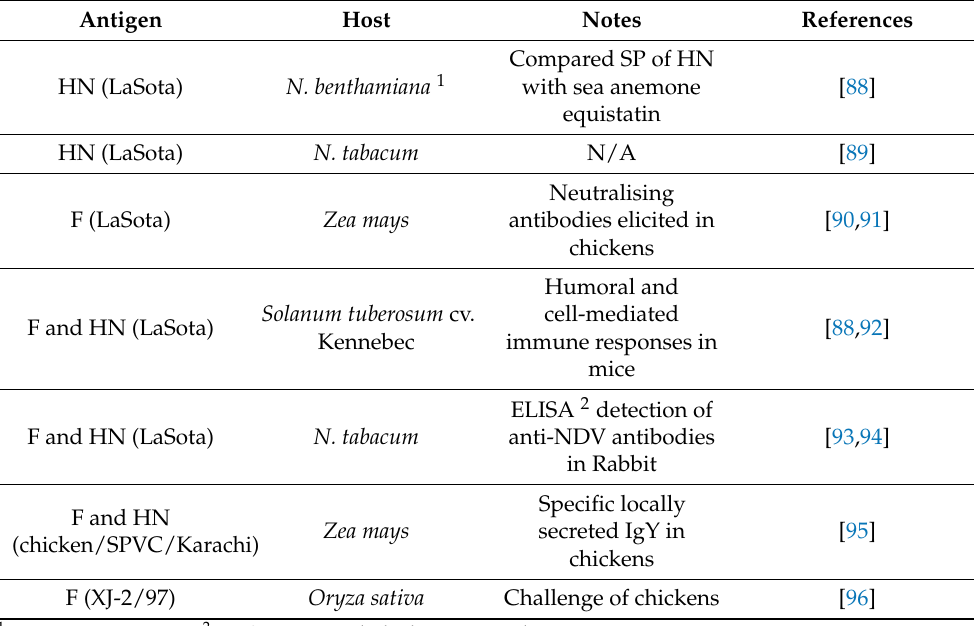
Table 4. Plant-based vaccines against Newcastle